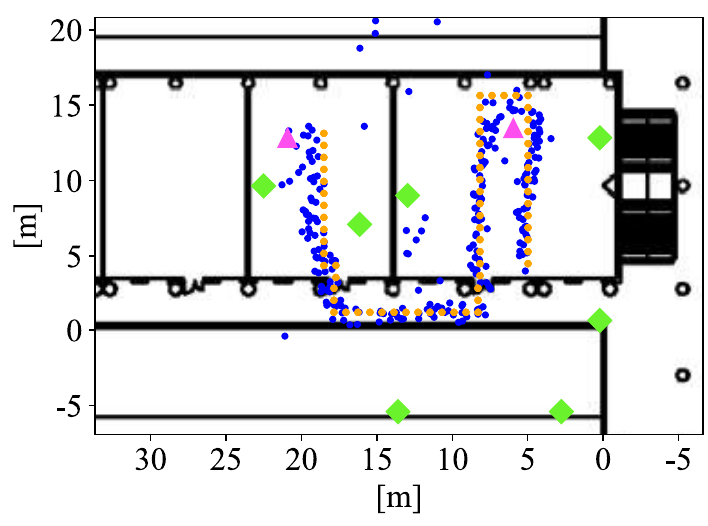
Figure 4. Localisation performance of Case 1 in 2D.